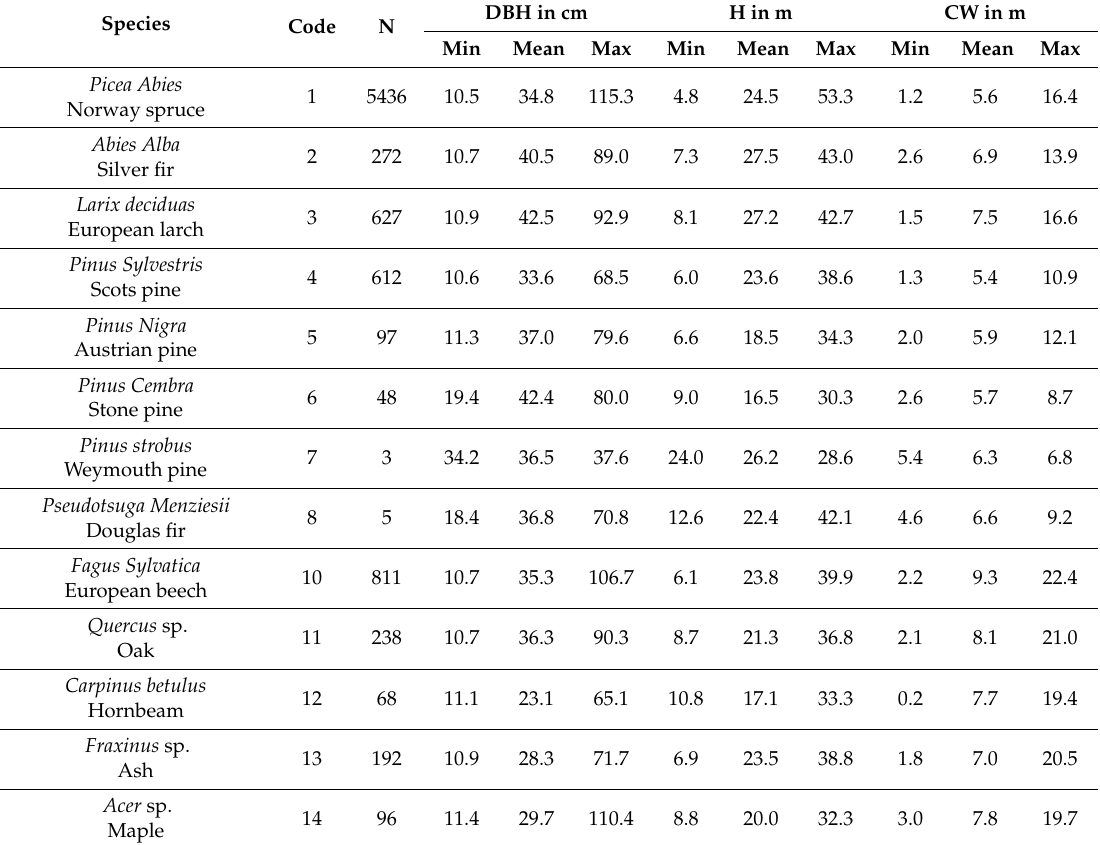
Table 2. Summary statistics for model fitting